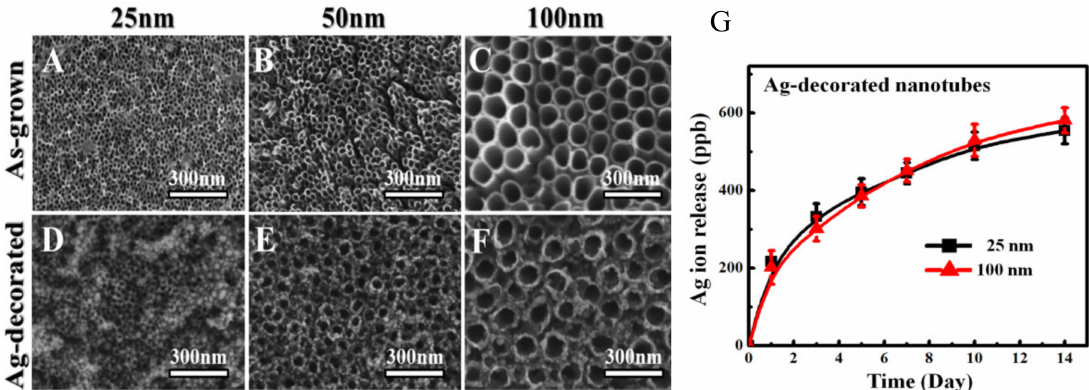
Figure 1. ( A – F ): SEM images of self-organized TiO 2 nanotubes with di ff erent diameters. The as-grown ( A – C ) and Ag-decorated ( D – F ) nanotubes with diameters of 25, 50 and 100 nm, respectively. G : Cumulative Ag release profiles from the 25- and 100-nm-diameter Ag-decorated nanotubes